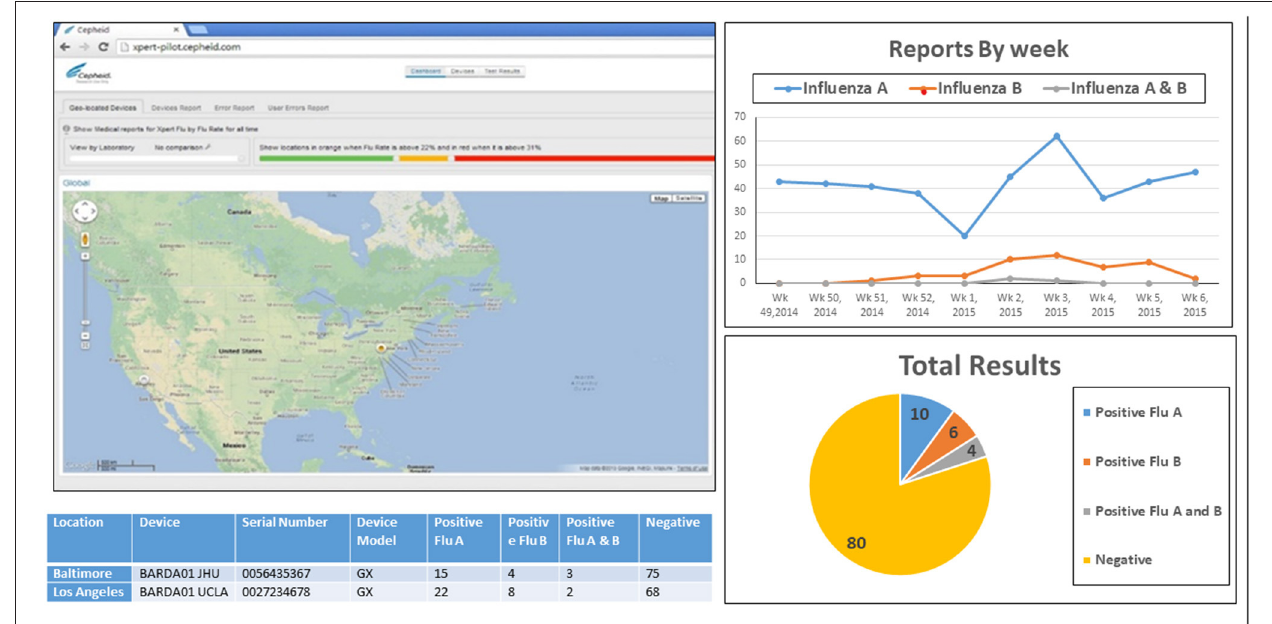
FIGURE 1 | Webpage of the real-time, cloud-based and laboratory-based influenza surveillance system. Visual of Web accessible dashboard which displayed influenza testing data in real-time (as tests were performed) from the two emergency department testing sites. Results shown (below map) were real time view of daily test counts, and test results (positive or negative) for influenza A and influenza B. Display of results could be manipulated by users to show seasonal trend (top), total cumulative test distribution to date (bottom) for each site or both sites combined (based on viewer access privileges).